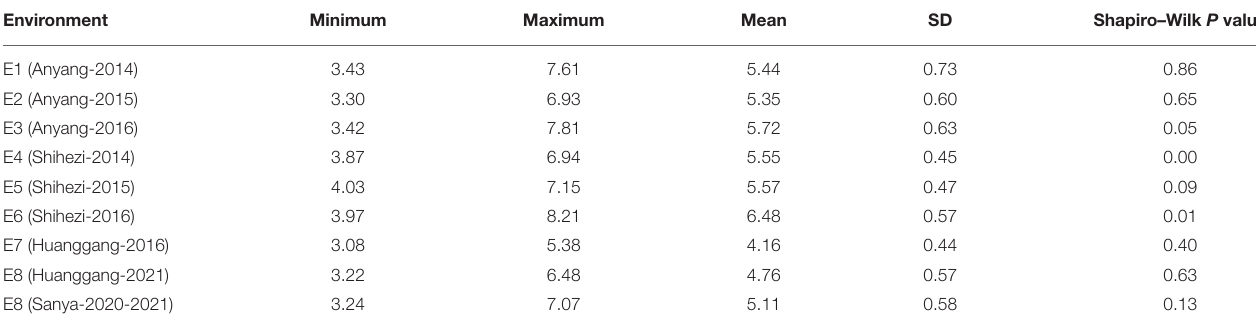
TABLE 1 | Phenotypic variation of BW in the natural